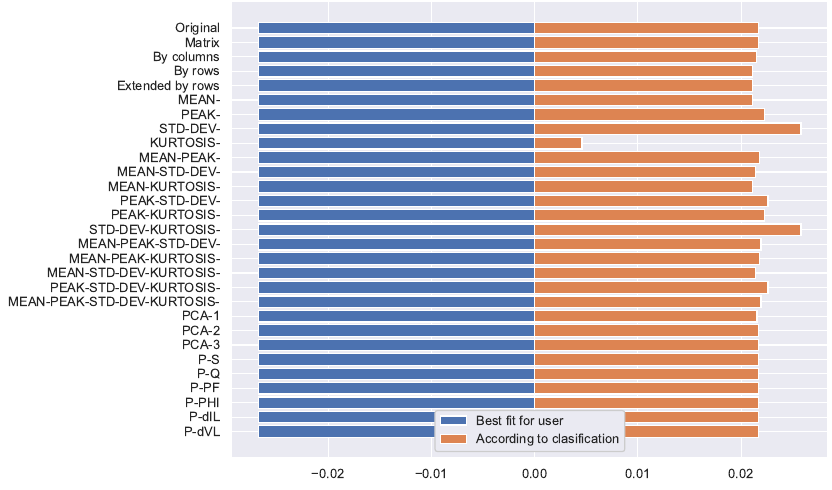
Figure 25. Relative changes of the